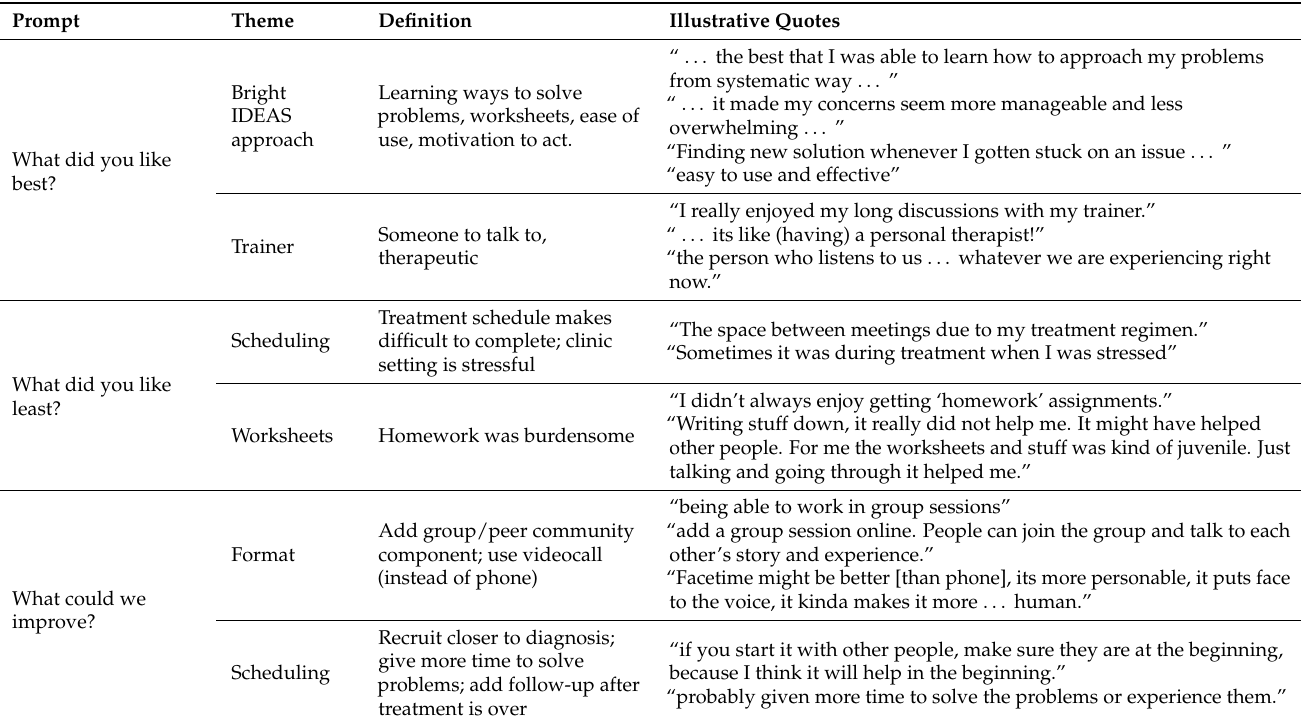
Table 3. Qualitative feedback about Bright